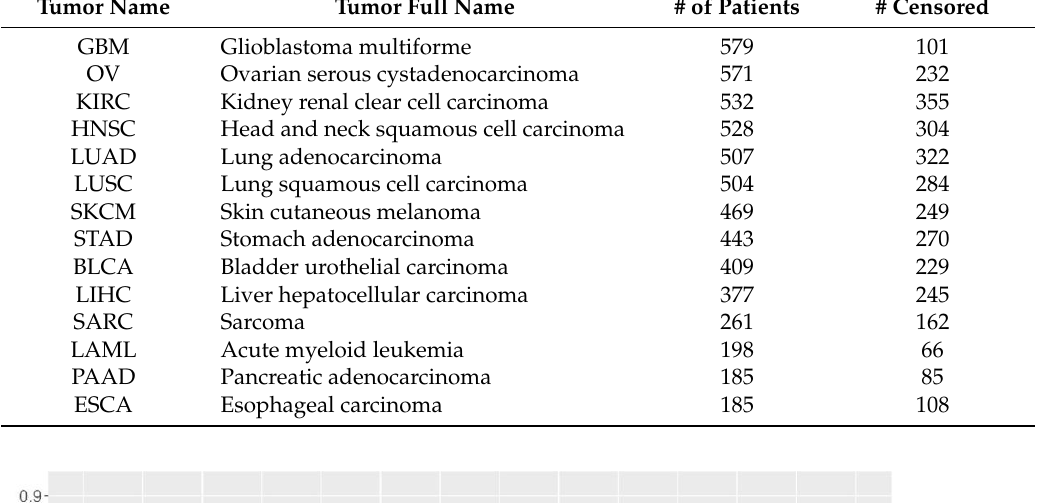
Table 1. Summary of the selected TCGA datasets. Only the TCGA tumor types with a ratio of non-censored over censored of no less than 0.3 and the number of patients no less than 100 were considered in the GDP analysis.